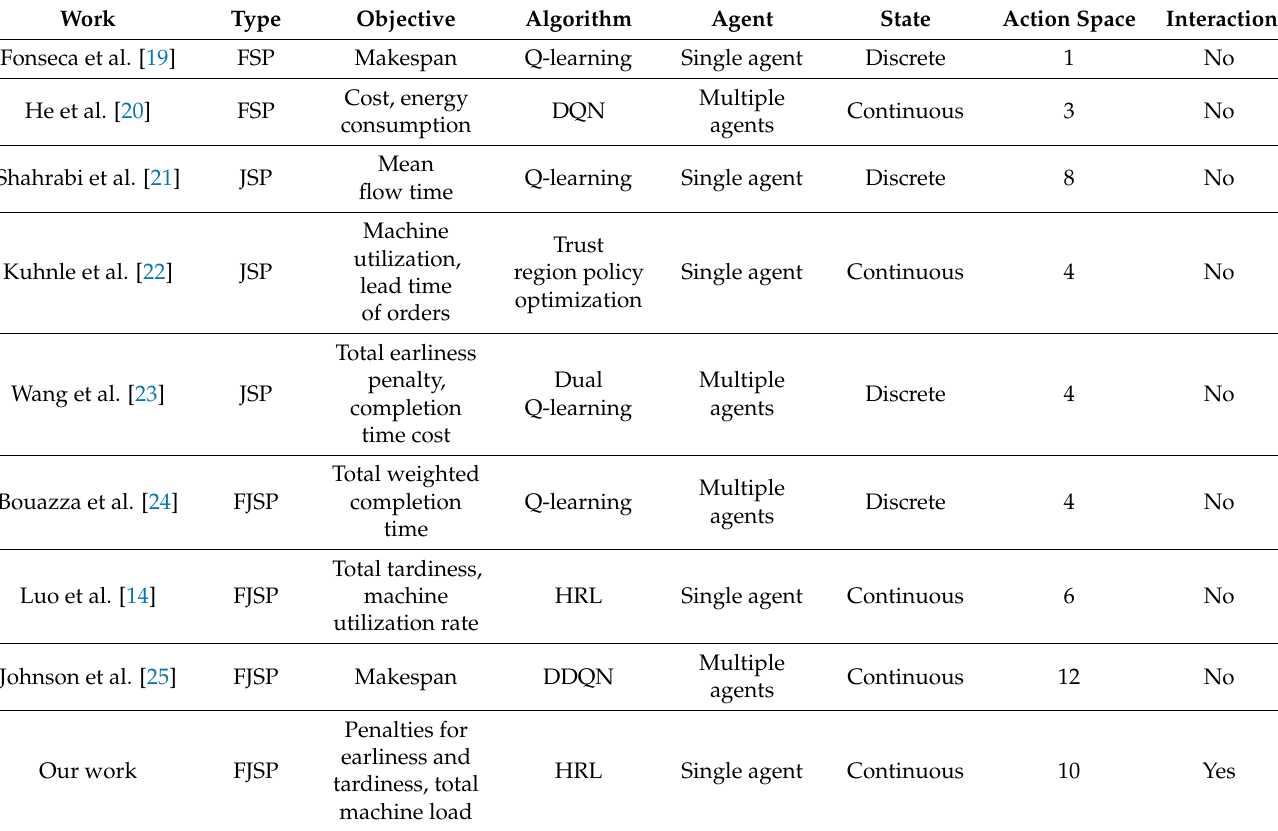
Table 1. Existing RL methods for dynamic production scheduling